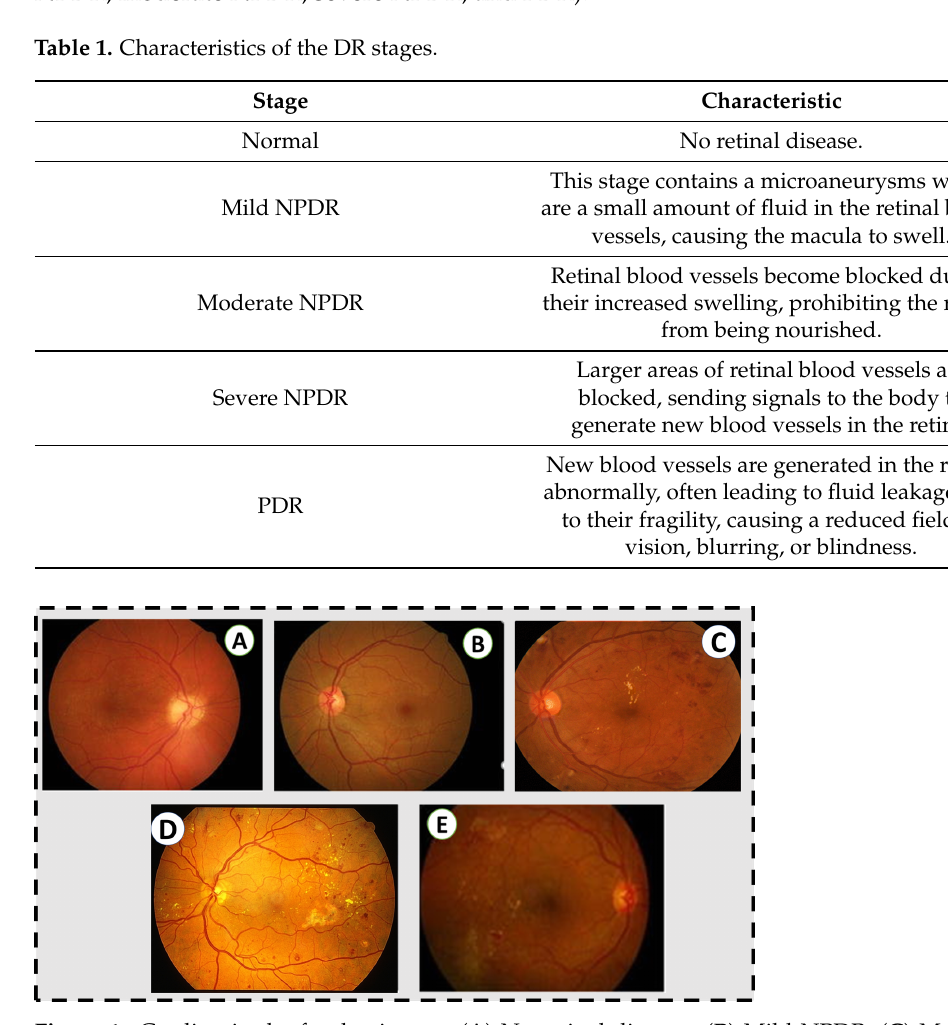
Figure 1. Grading in the fundus image. ( A ) No retinal disease. ( B ) Mild NPDR. ( C ) Moderate NPDR. There are some microaneurysms, dot and blot hemorrhages in the temporal macula, and a few flecks of lipid exudate, but no venous beading or other microvascular abnormalities. ( D )